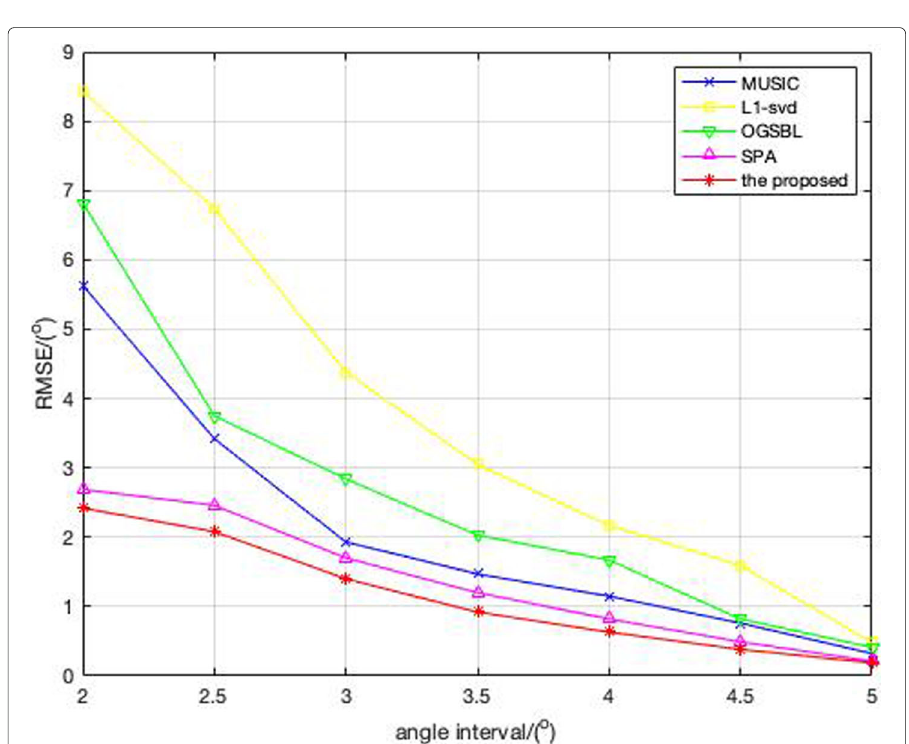
Fig. 5 RMSEs of five algorithms versus angle